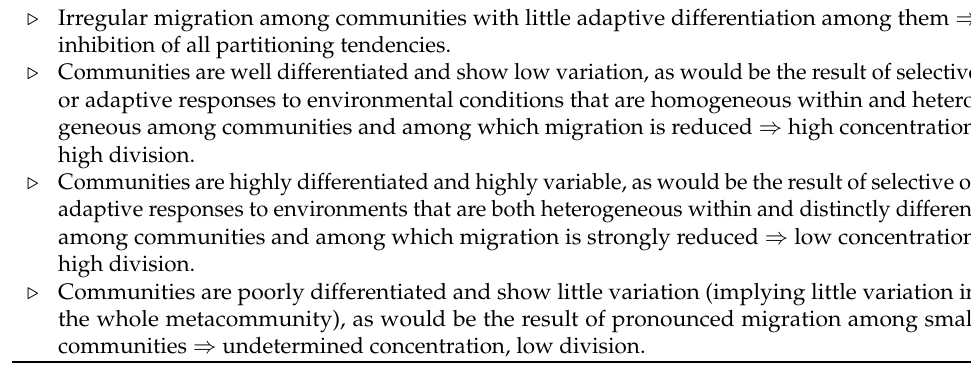
Table 1. Some ecological conditions and evolutionary forces and their relation to tendencies of community concentration and